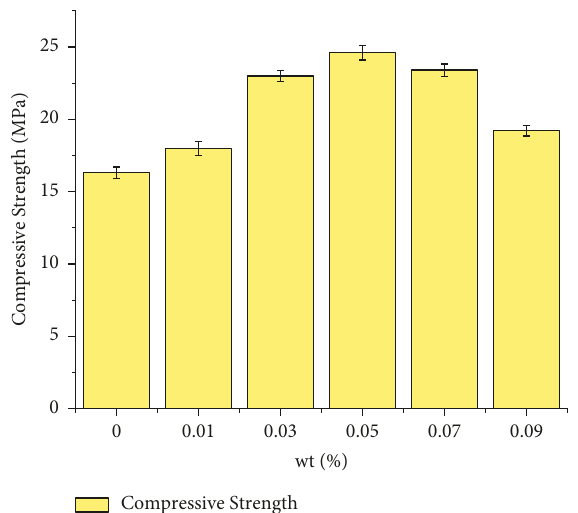
Figure 5: Flexural strength test of ZRJ-S1 reinforced cement-based materials.